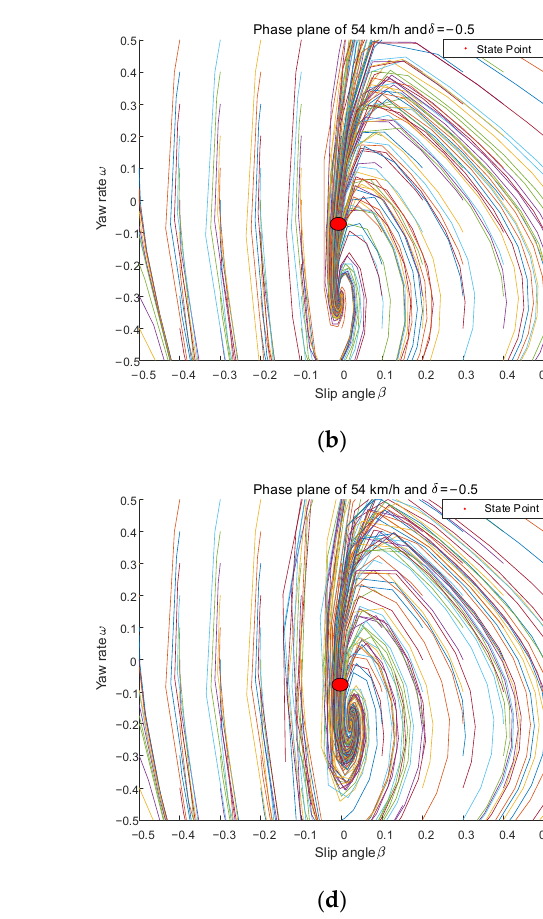
Figure 4. Phase plane at different speeds and front wheel angles. ( a ) Phase plane of 36 km/h and δ = 0.5 rad; ( b ) phase plane of 36 km/h and δ = −0.5 rad; ( c ) phase plane of 54 km/h and δ = 0.5 rad; ( d ) phase plane of 54 km/h and δ = −0.5 rad.